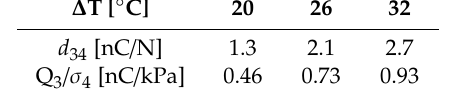
Table 3. Approximate slopes of the characteristic curves shown in Figure 7a and the moduli d 34 calculated by solving Equation (7) as a function of temperature.